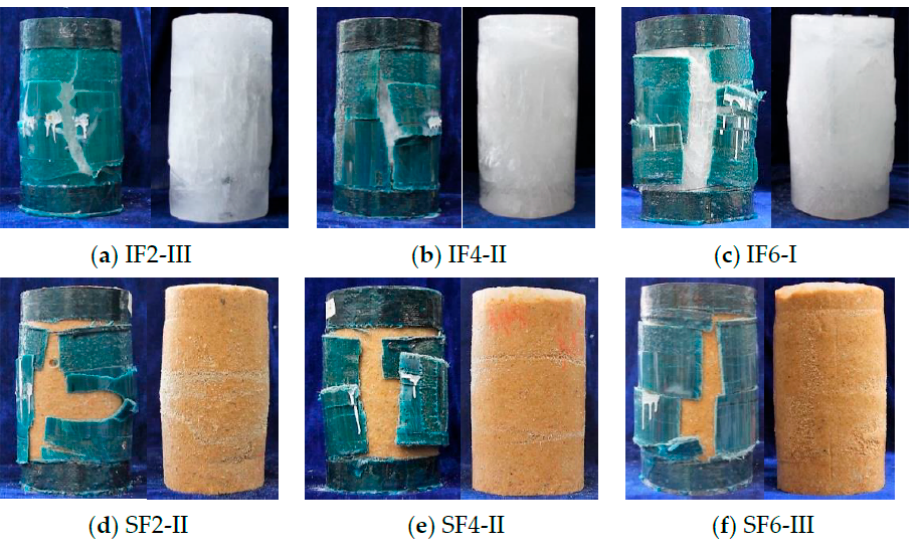
Figure 6. ( a – f ) Typical failure modes of PIFFT and SIFFT specimens (IF and SF representing PIFFT and SIFFT, respectively; Arabic numeral representing the number of flax FRP layers; and Roman numeral differentiating three nominally identical specimens).